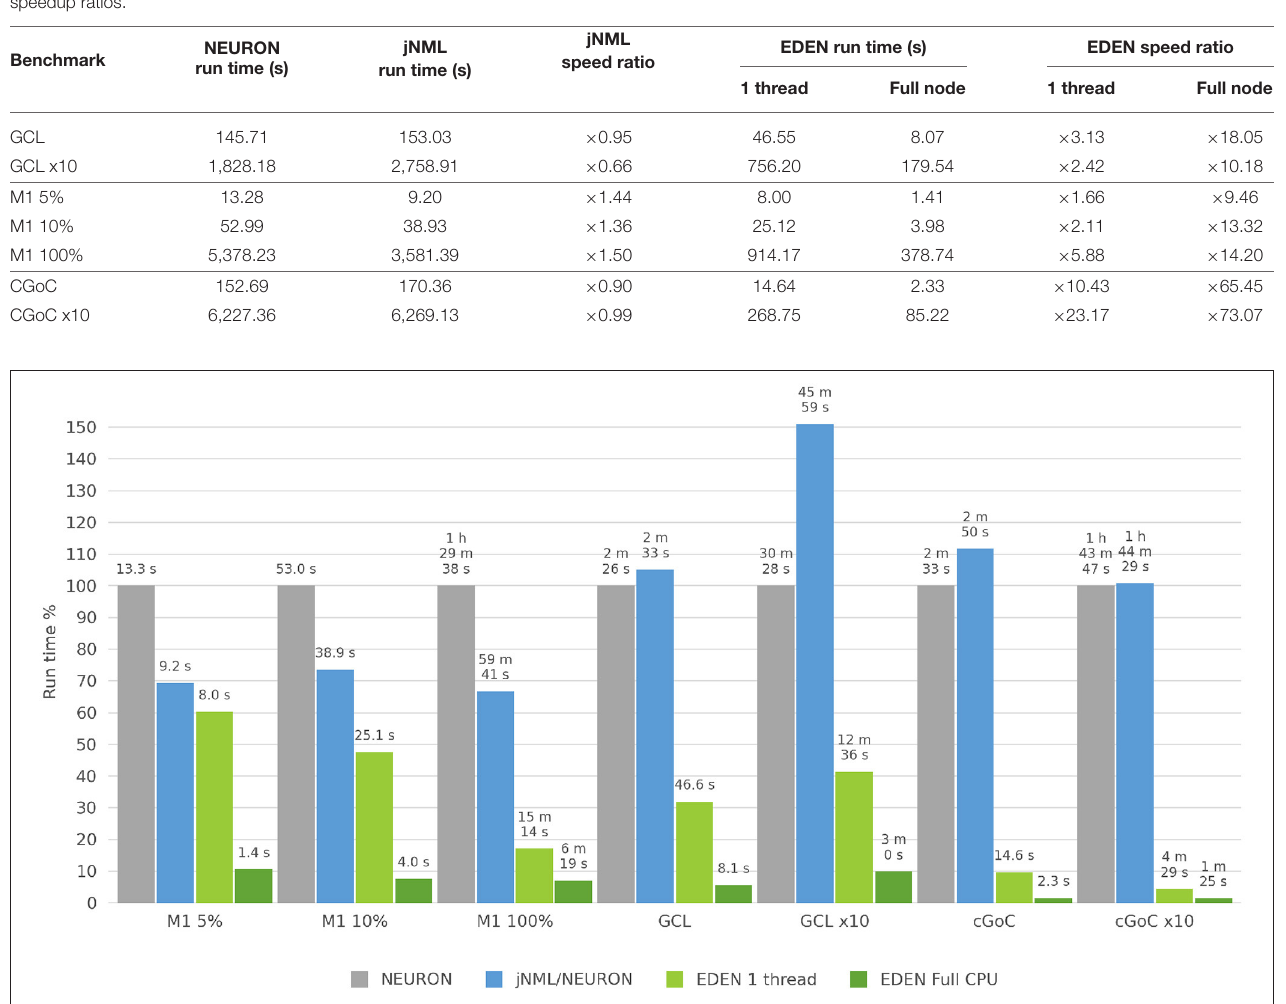
FIGURE 10 | Run time for each neural network considered, for NEURON versus jNeuroML/NEURON and versus EDEN on one CPU thread and on all CPU threads. For each neural network, benchmark the bar height in the chart is normalized against NEURON’s run time for that